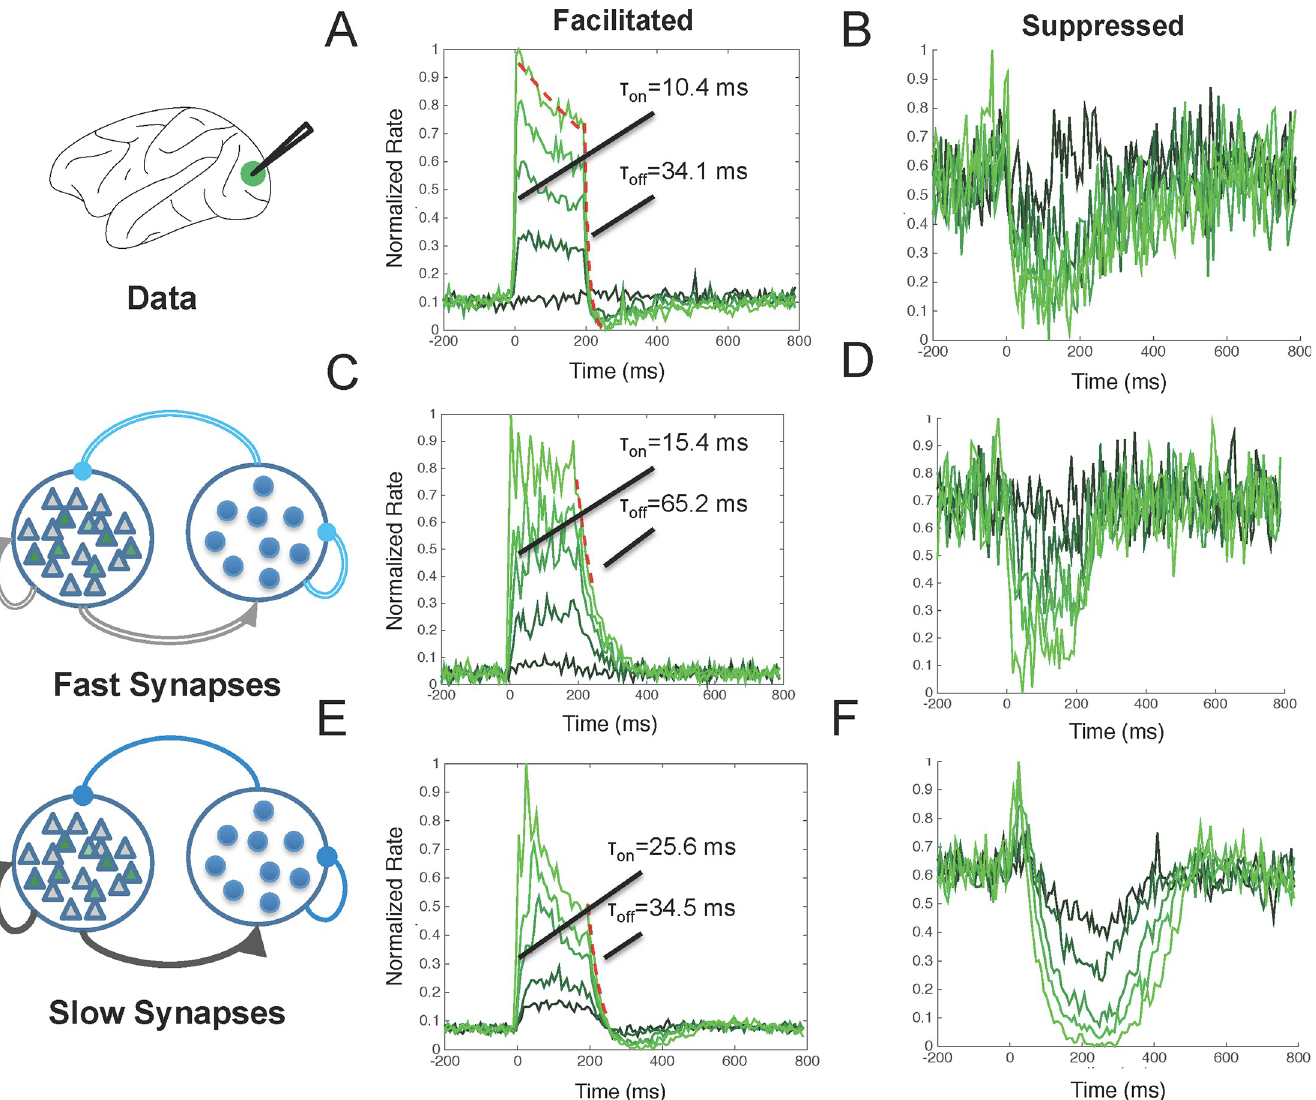
Fig 3. Model comparison with the full temporal response profile seen in the data. A,B) Temporal response profile during optogenetic stimulation for facilitated (Fig 3A) and suppressed (Fig 3B) neurons in macaque V1. B-E) The full response profile of the models developed in Fig 2A, including a model with fast synapses (Fig 3B and 3C) and a model with slow synapses (Fig 3D and